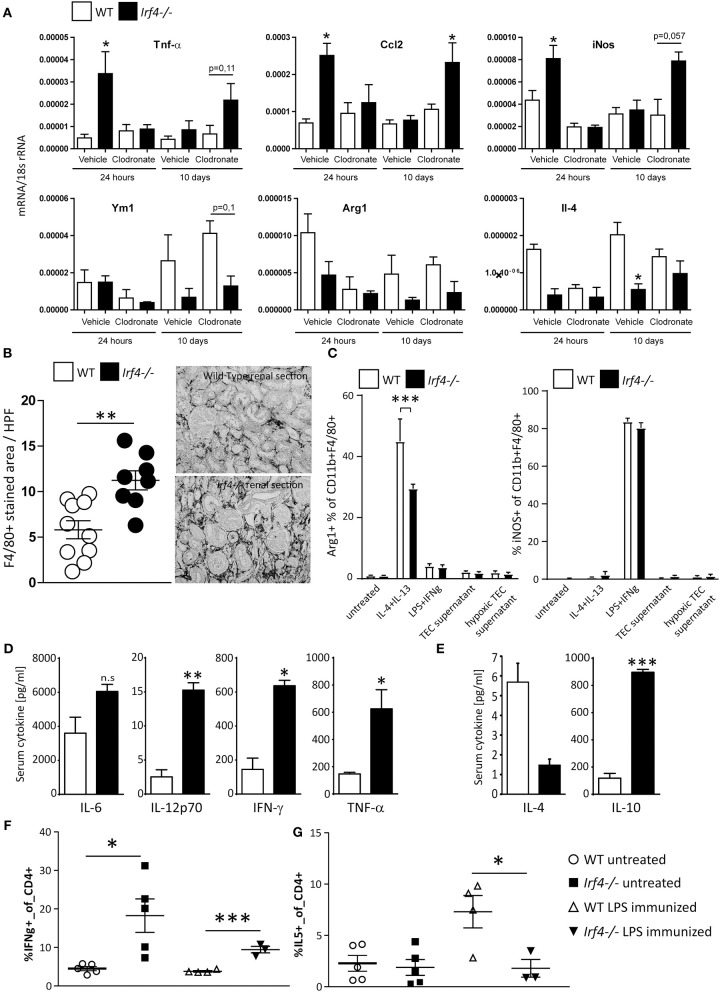
(A) Wild type and IRF4-deficient mice underwent unilateral IR after having received an i.v. injection of control liposomes or clodronate that depletes macrophages and DCs. Clodronate treatment prevented renal inflammation seen in untreated IRF4-deficient mice and evidenced by intrarenal expression of pro-inflammatory mediators. Data are expressed as mean of the ratio vs. the respective 18s rRNA level ± SEM. *p < 0.05 vs. wild type. (B) Sections of kidneys of WT and Irf4−/− mice were stained for F4/80, 5 weeks after unilateral IRI. Number of infiltrating macrophages was assessed as stained area per HPF (n = 8–10 animals per group; each dot represents the average of at least three high-power fields per animal). (B,C) BMDMs from WT and Irf4−/− mice were cultured and stimulated with IL-4 and IL-13 as M2 differentiating agents, or LPS + IFN-γ for M1 differentiation. Flow cytometric analysis was performed for M2 (Arg1+) and M1 (iNOS+) CD11b+ and F4/80+ cells. (D,E) Mice were injected with LPS. Mice were euthanized after 12 h to obtain plasma samples for determination of the indicated cytokines. (F,G) Flow cytometry of spleen T-cell populations was performed from WT and Irf4−/− mice under normal conditions and 12 h after injection of LPS. Intracellular staining for IFN-γ or IL-5, respectively, was used to differentiate Th1 and Th2 type T-cell responses. *p < 0.05, ***p < 0.001; **p < 0.01.